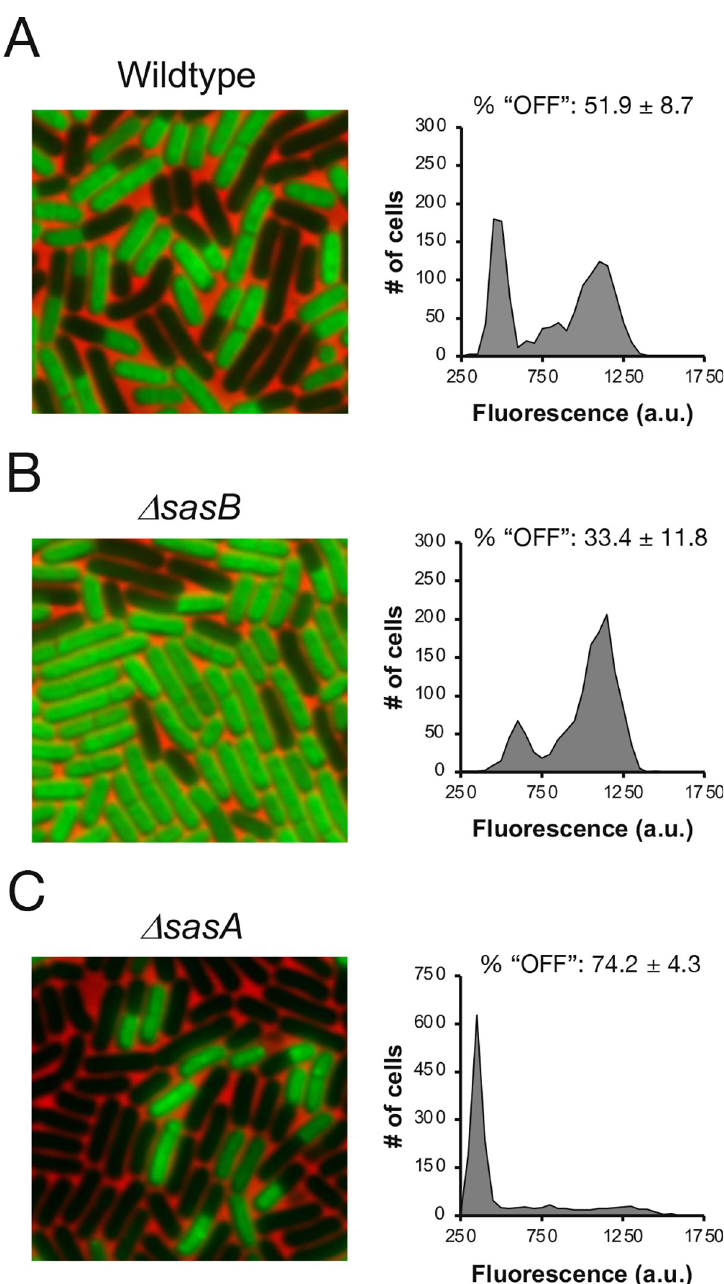
Fig 1. sasB and sasA have opposite effects on bimodality. (A, B, C) Representative pictures and population distributions of OPP labeled (A) wildtype (JDB1772), (B) Δ sasB (JDB4310) and (C) Δ sasA (JDB4311) during late transition phase. % of population “OFF” as determined in S1 Fig presented above each representative distribution. Statistical significance was determined by comparing three independent populations of WT to either mutant. P-values are 0.046 and 0.011 for Δ sasB and Δ sasA